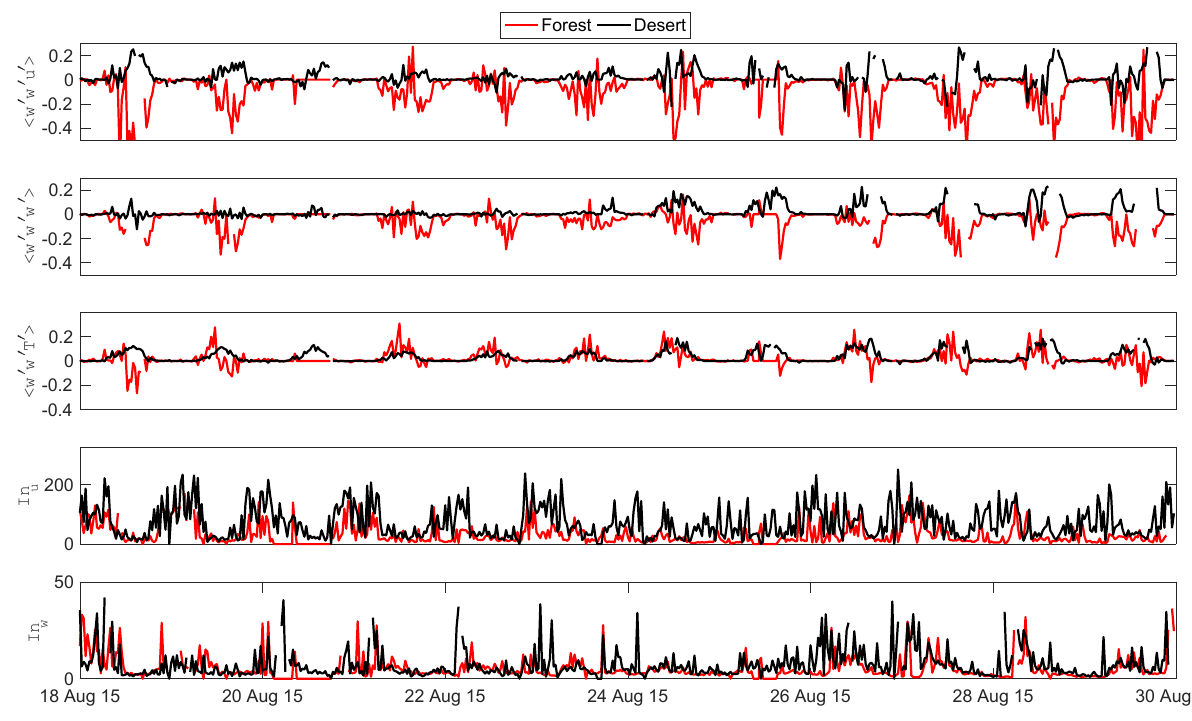
Figure 6. Top three panels: time series of triple moments w (cid:48) w (cid:48) u (cid:48) , w (cid:48) w (cid:48) w (cid:48) (m 3 s − 3 ) and w (cid:48) w (cid:48) T (cid:48) (Km 2 s − 2 ). Bottom two panels show the integral timescales of horizontal (In u ) and vertical velocities (In w ) in seconds.